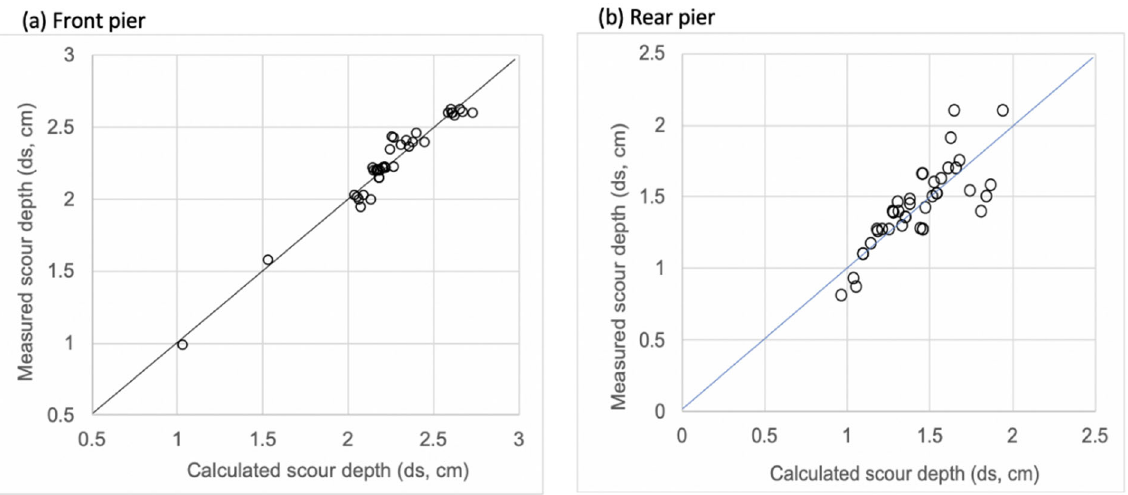
Figure 12. Comparison between calculated scour depths and those of observations. ( a ) Front pier; ( b ) Rear pier)